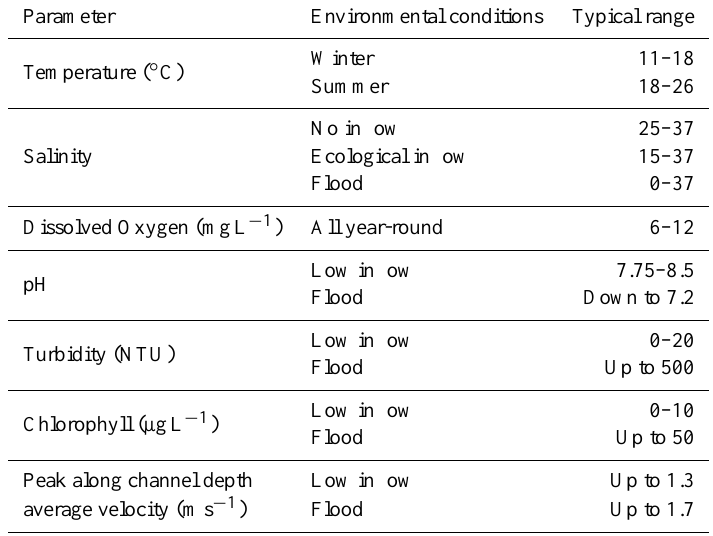
Table 3. Typical range of variations of parameters recorded by the SIMPATICO Station. Winter refers to November–May, and summer